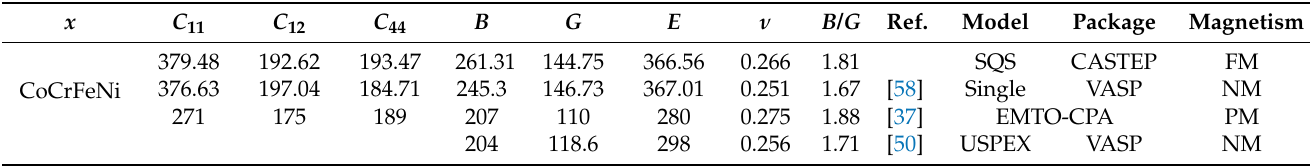
Table 3. Elastic constants ( C ij ) and polycrystal elastic moduli ( B , G , E , ν , and B / G ) for CoCrFeNi alloy. The unit is GPa, except for the dimensionless ν and B / G